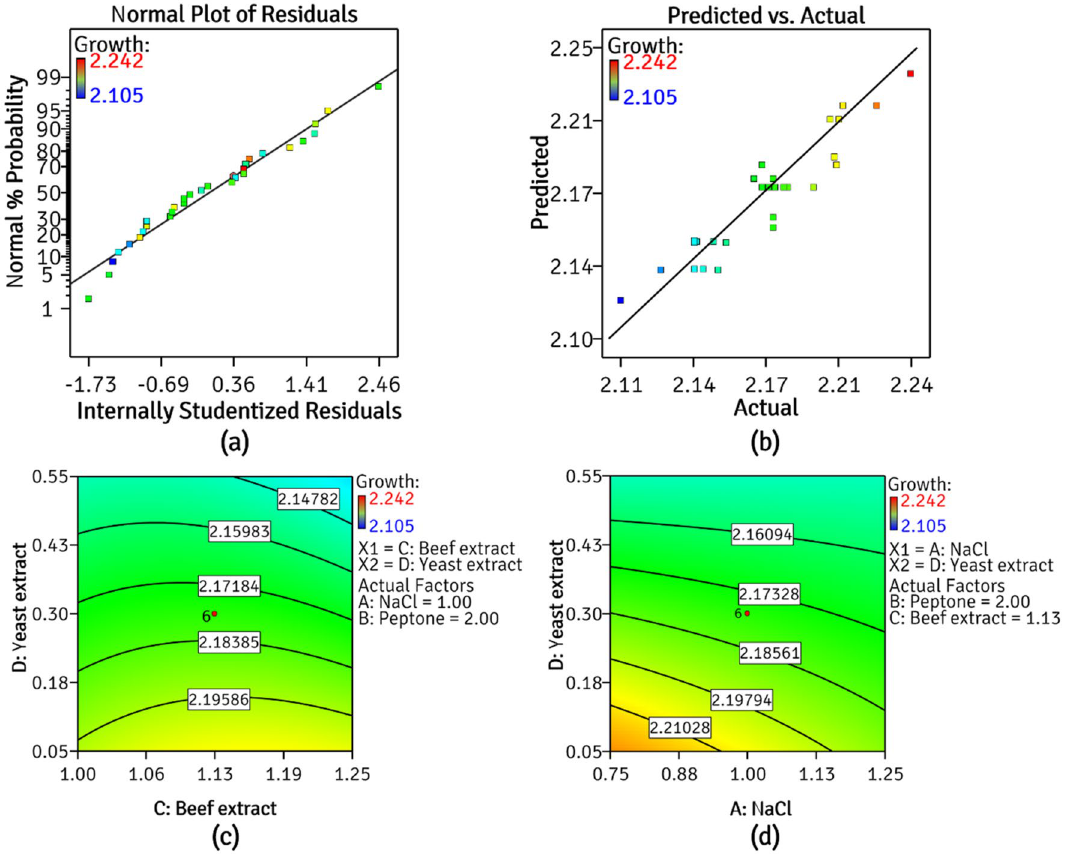
Figure 4. CCD results ( a ) normal probability plot ( b ) predicted vs actual plot ( c ) and ( d ) contour plots depicting significant interactions of NB components on growth of P. thoriotolerans AM3 (image created in Design-Expert